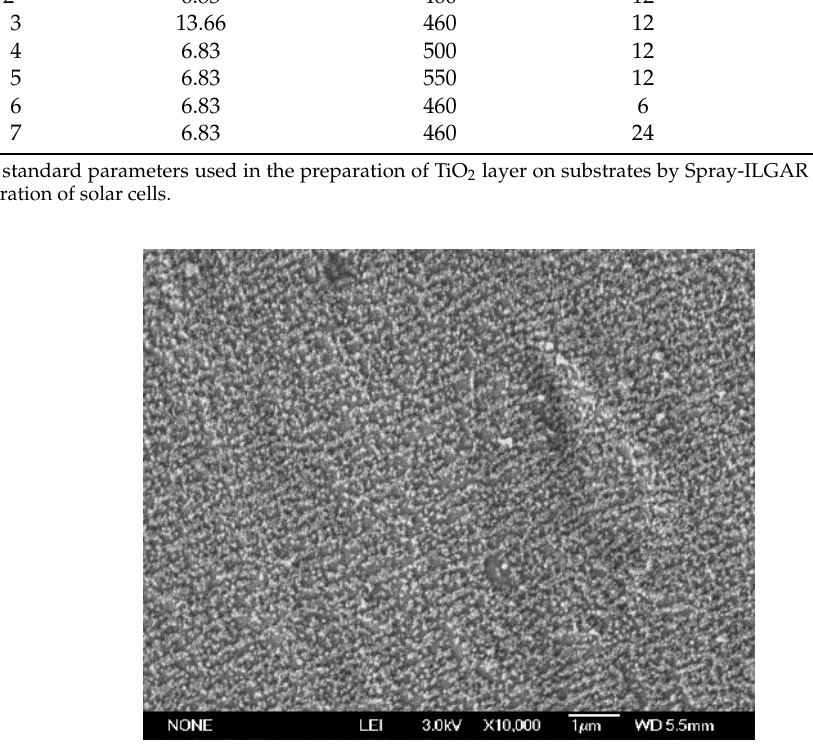
Figure 1. SEM image of TiO 2 on stainless steel by Spray-ILGAR technique using 6.83 mM of titanium diisopropoxide bis(acetylacetone) alcoholic solution, heated at 460 °C and spraying time of 12 min.